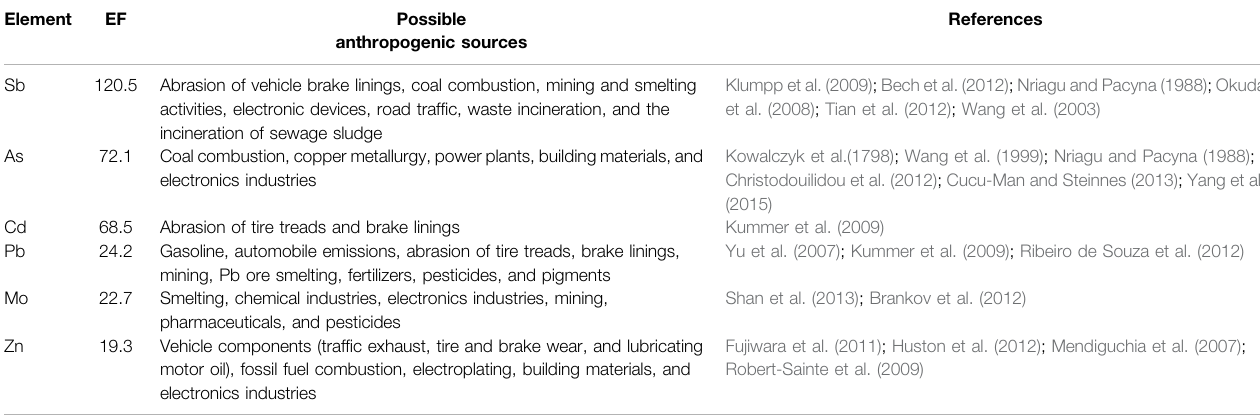
TABLE 5 | Enrichment factors (EFs) of > 10 NIES CRM No. 28 and possible anthropogenic sources.